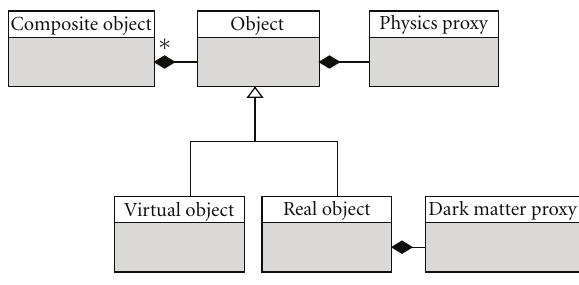
Figure 2: A class diagram of objects used in the MARG